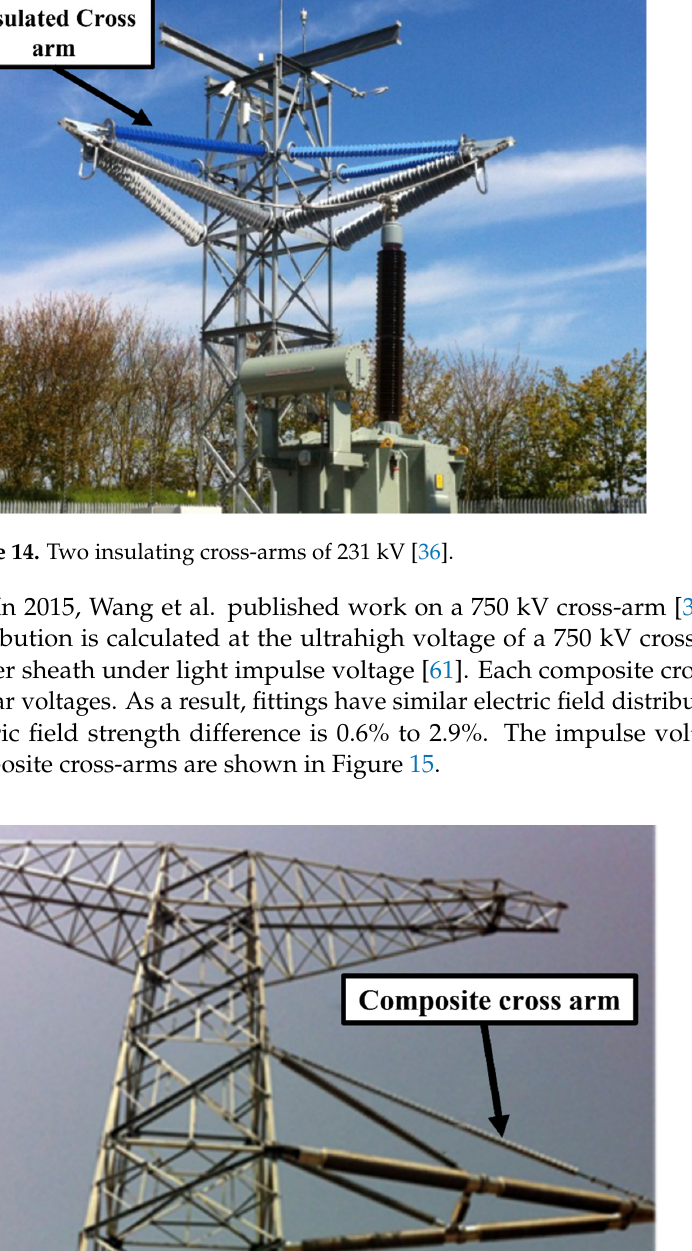
Figure 13. Full ‐ scale prototype cross ‐ arm [35].